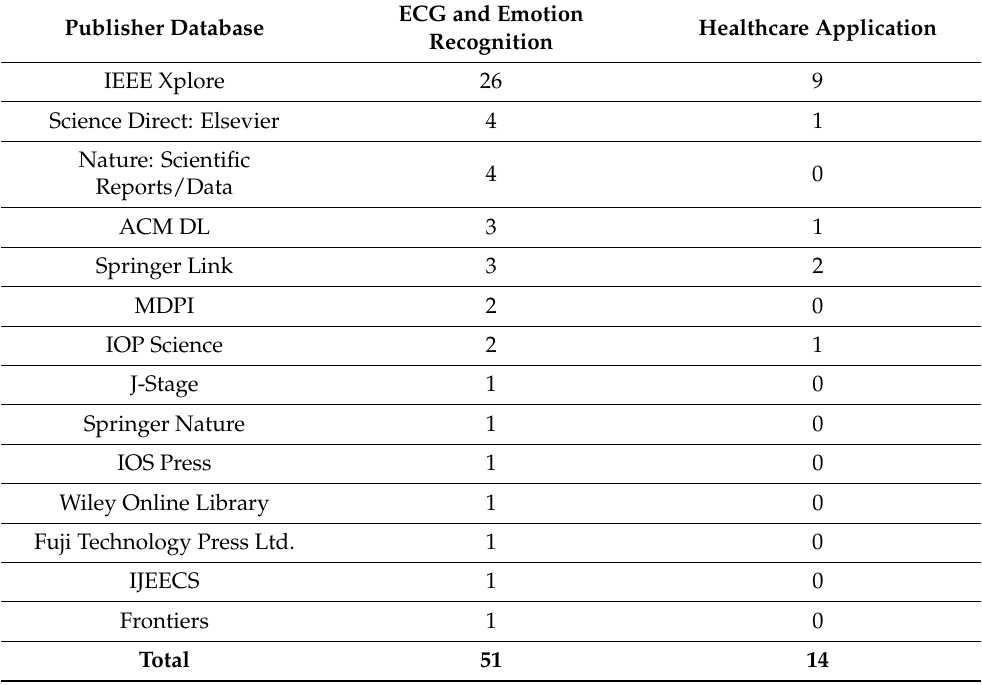
Table 1. Number of papers reviewed from the respective databases.